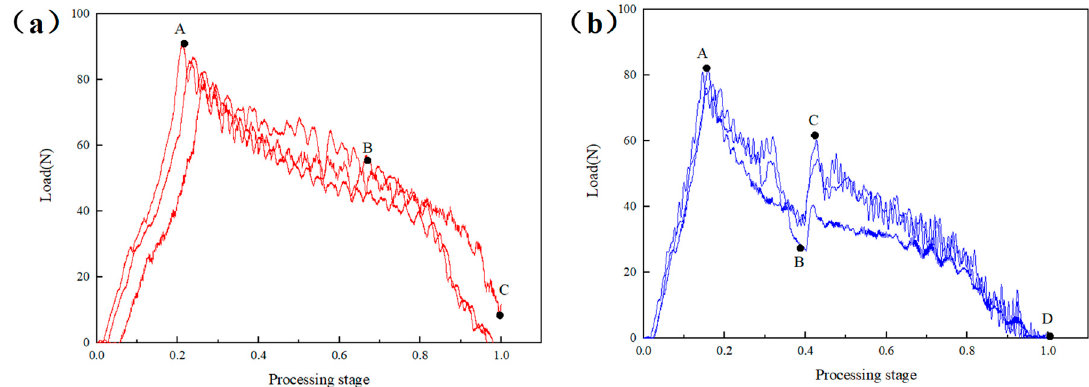
Figure 6. Axial force time curves of constant and dynamic feed speeds with rotation speed of 4000 r/min: ( a ) Constant feed speed 10 mm/min, ( b ) Dynamic feed speed 10–5 mm/min.